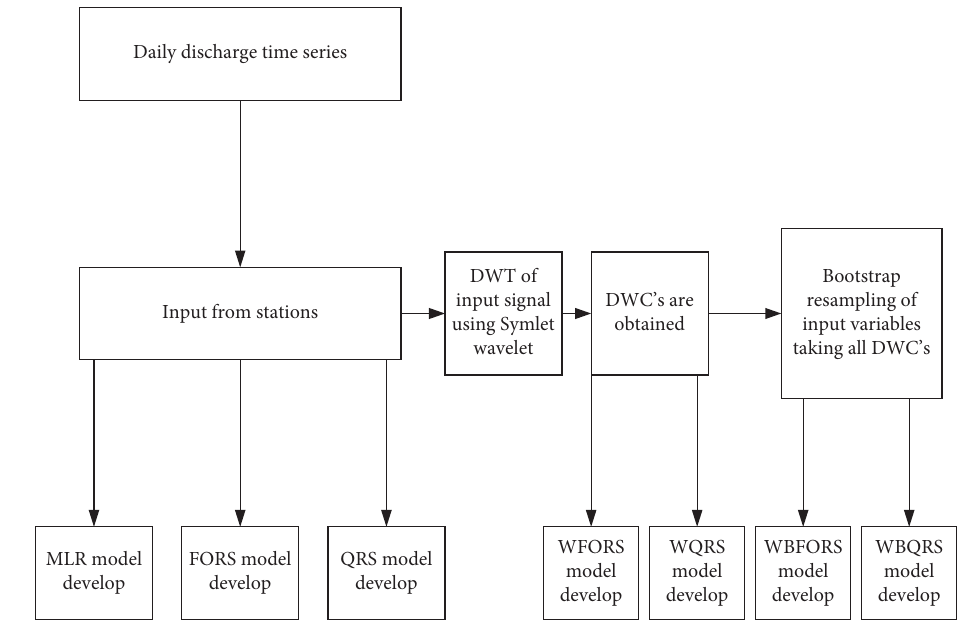
Figure 4: Te fowchart illustrates the proposed model development. Table 4: Statistical indicator for MLR, FORS, QRS, WFORS, WQRS, WBFORS, and WBQRS models.